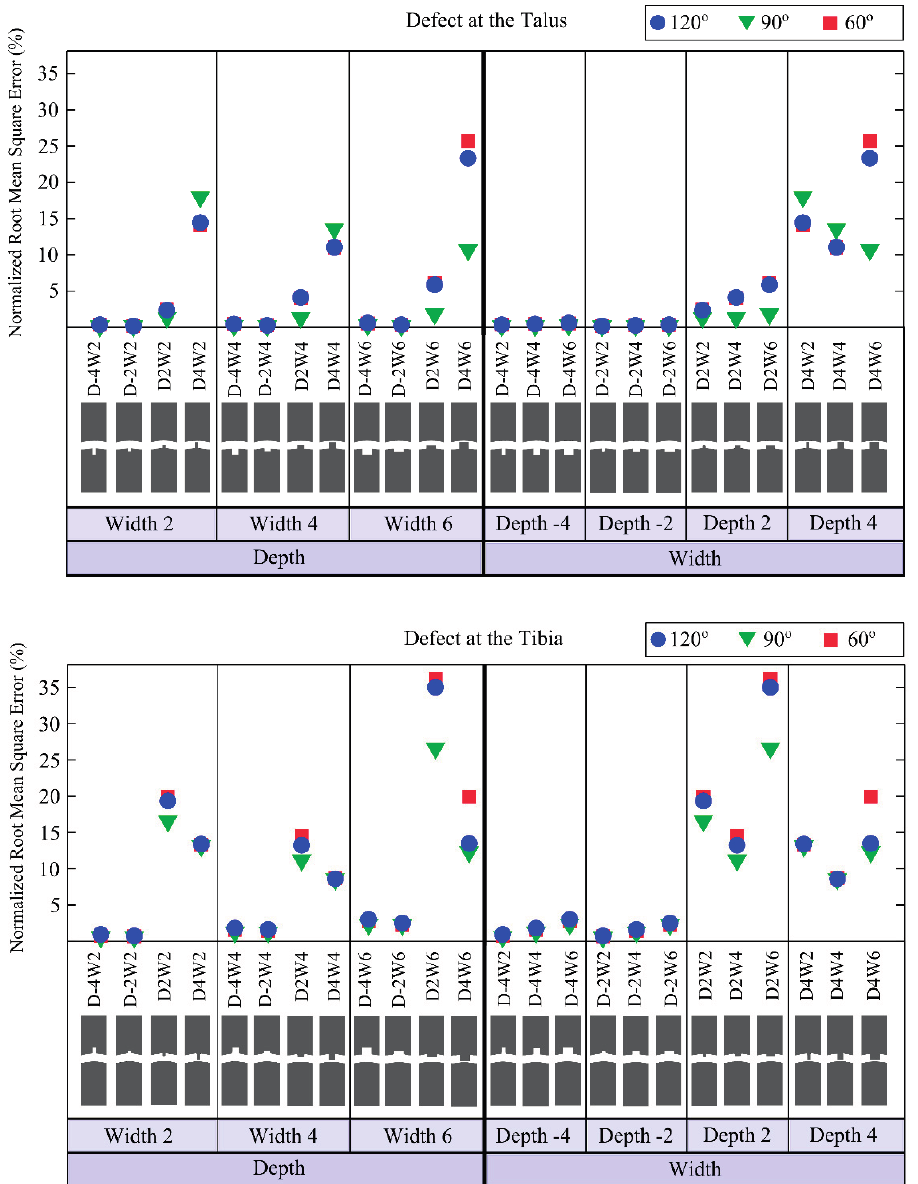
Figure 8. Normalized root mean square errors (NRMSE) for models simulating defects located on the talus ( i.e. , first graph) and on the tibia ( i.e. , second graph). The first three columns of the first and second graphs are provided to clearly represent the effects of varying defects depths when the defect width was fixed at 2 mm, 4 mm or 6 mm. The last four columns are presented to easily capture the changes related to the varying defects widths when the defect depth was fixed at − 4 mm, − 2 mm, 2 mm or 4 mm. Negative values for defect depth are used to represent actual holes in the bone, while positive values are used to describe positive defects, which may occur in the stage IV lesions ( i.e. , detached and displaced osteochondral fragment). In the first and second graphs, depth and width of defect are represented by a “D” and a “W”, respectively. The minus sign “-” is used to describe negative defect, an actual hole in the bone (e.g., D-2W6 represents negative defect, i.e. , a hole, with a depth of 2 mm and a width of 6